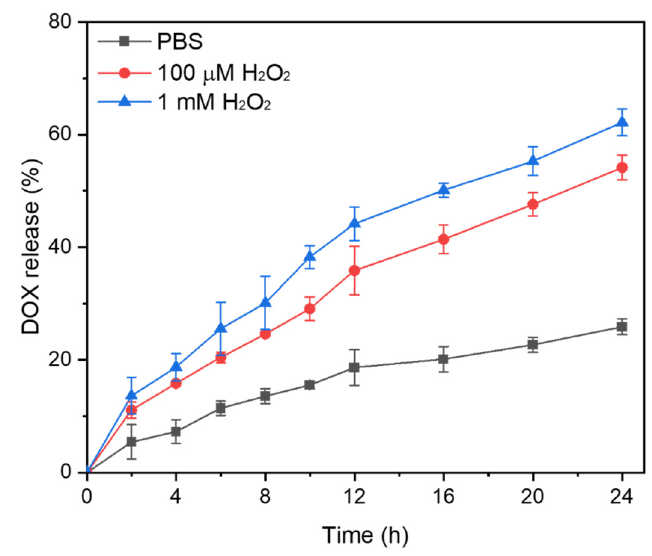
Figure 4. In vitro release profiles of DOX from DOX-loaded micelles subjected to different H 2 O 2 concentrations. Data are means ± S.D. of three independent experiments.